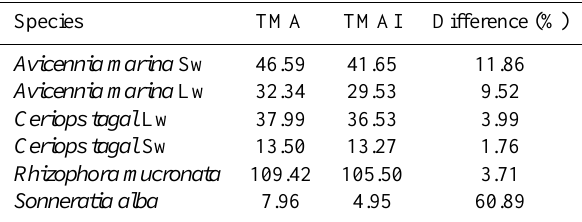
Table 2. Presentation of the total area (ha) occupied by each man- grove species with the whole studied area (TMA) and the total area occupied by each mangrove species within the inundation classes at present (TMAI). Sw=seaward side and Lw=landward side.